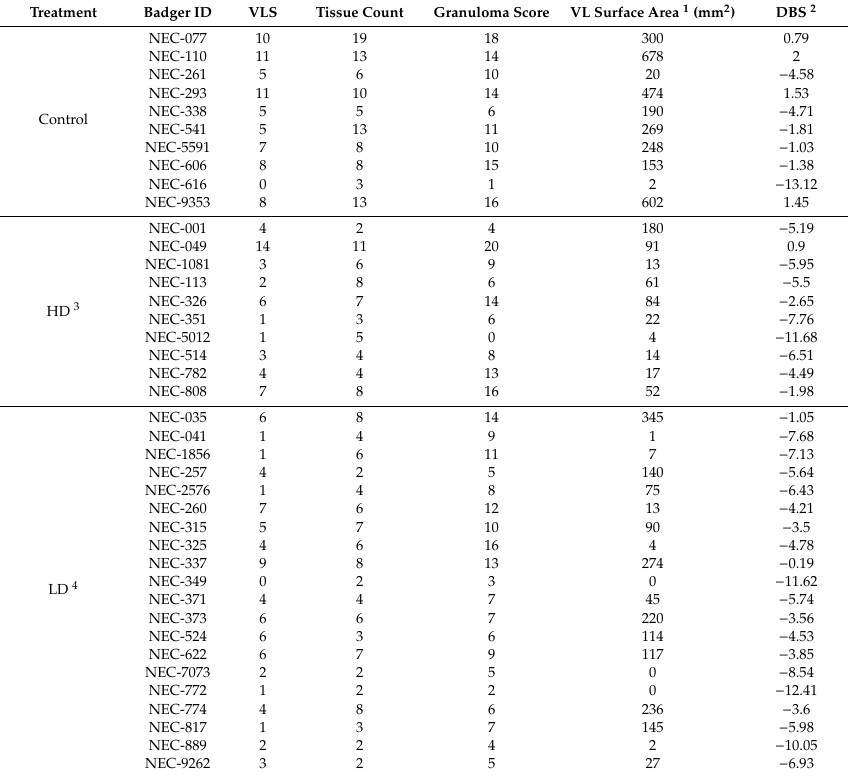
Table 3. Burden of disease for each animal post mortem in VES9, as assessed by four di ff erent measures, as described